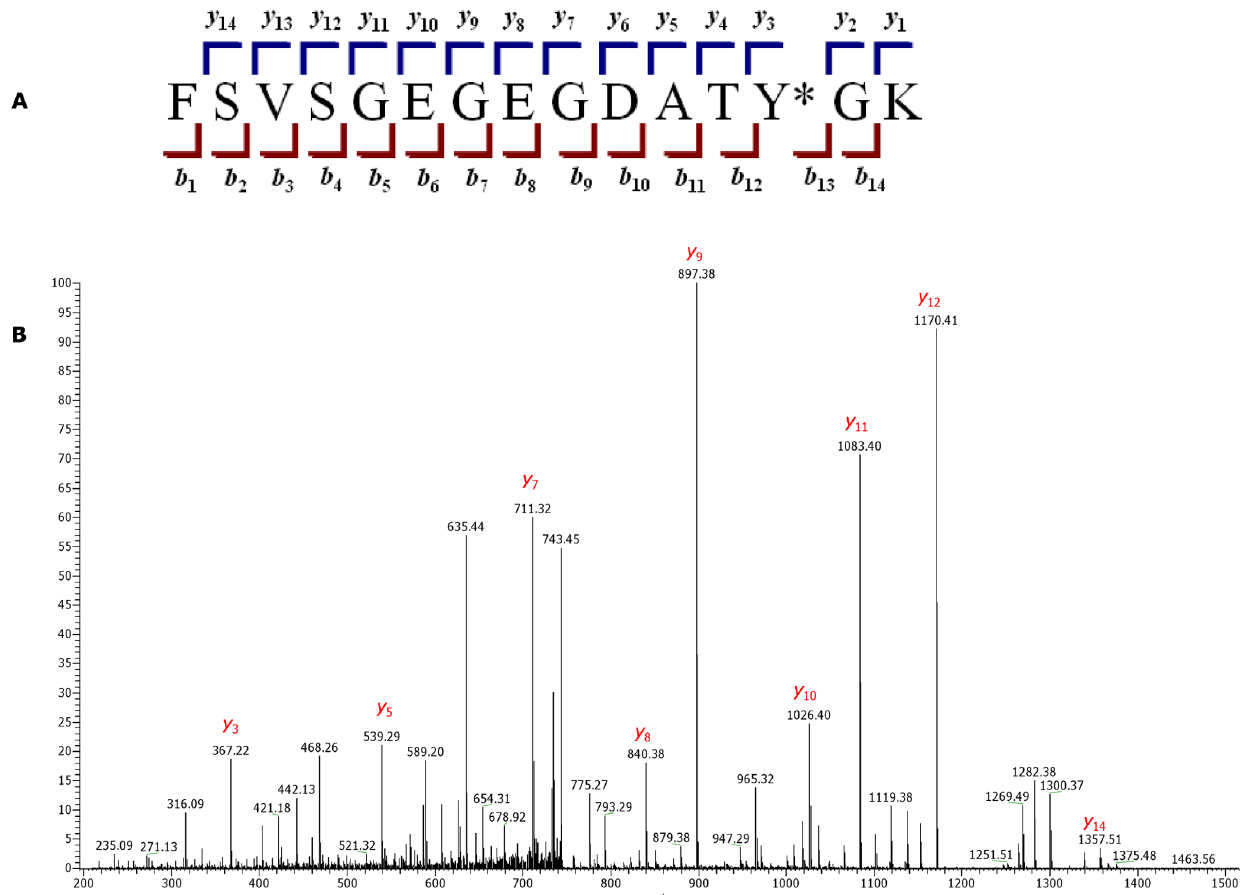
Figure 4. Site-specific Bpa incorporation into GFP in a cell-free expression system. (A) Western blot visualization of WT GFP and Bpa- incorporating GFP Y39TAG. The synthesis of GFP was performed using an in vitro translation kit. Co-translational incorporation of Bpa was achieved by addition of M. jannaschii BpaRS (100 m g/mL), different types of suppressor tRNA (480 m g/mL) and Bpa (1 mM) to the reaction medium. tRNA denotes synthetic Mj tRNA CUA , Opt – tRNA CUAOpt . (B) Annotated MS/MS spectrum of the FSVSGEGEGDATY*GK peptide from GFP Y39Bpa. The mass shift of 88 Da between Bpa in GFP Y39Bpa and tyrosine in WT GFP is clearly observed. For clarity, only the most abundant ‘‘y’’ ions are assigned.